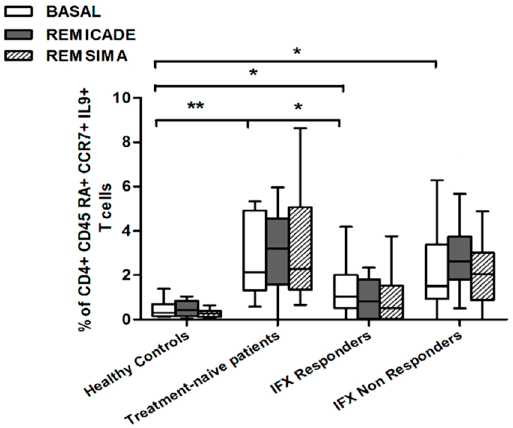
Figure 3. Percentages of CD45RA + , CCR7 + , IL-9 + CD4 + (naïve) T cells at baseline and after exposure to branded and biosimilar infliximab. * p < 0.05, ** p <0.01.